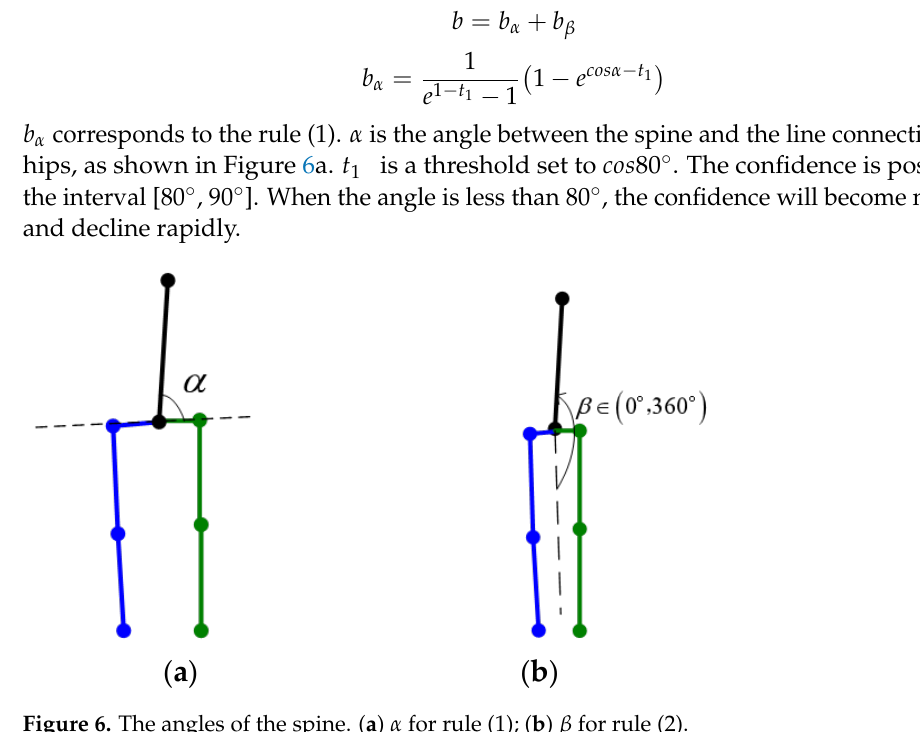
The curves of 𝑏 𝛼 and 𝑏 𝛽 are shown in Figure 7.